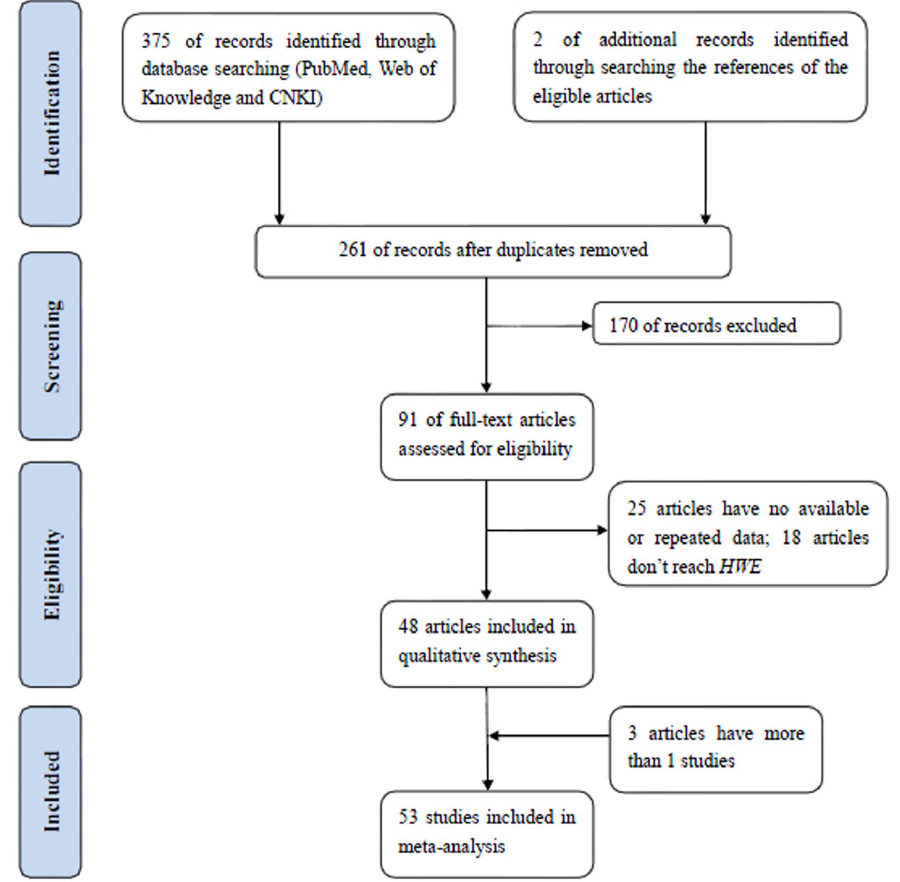
Figure 1. Flow diagram of the study selection process.